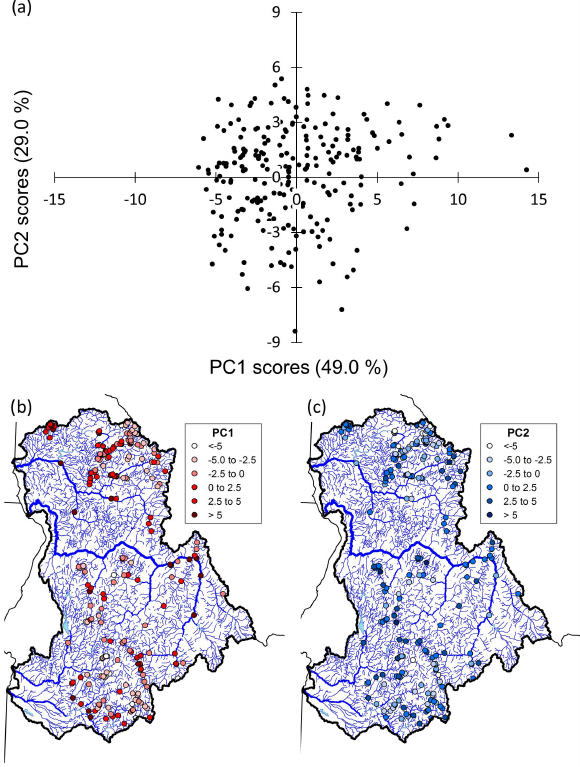
Figure 4. Ordination plot that shows principal component scores of the first two axes derived from water temperature data measured at 226 sites and summarized with 28 thermal metrics (a) . (b) and (c) show principal component scores mapped to network